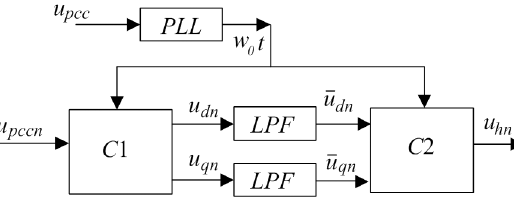
Fig 8. Sing-order Single-phase harmonic detection